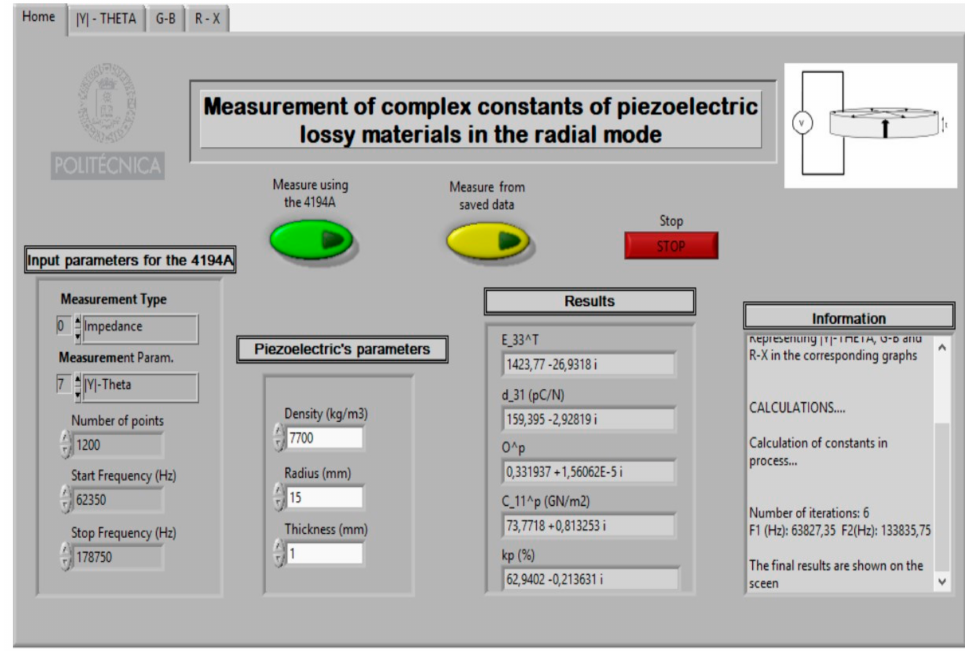
Figure 14. Results of test.